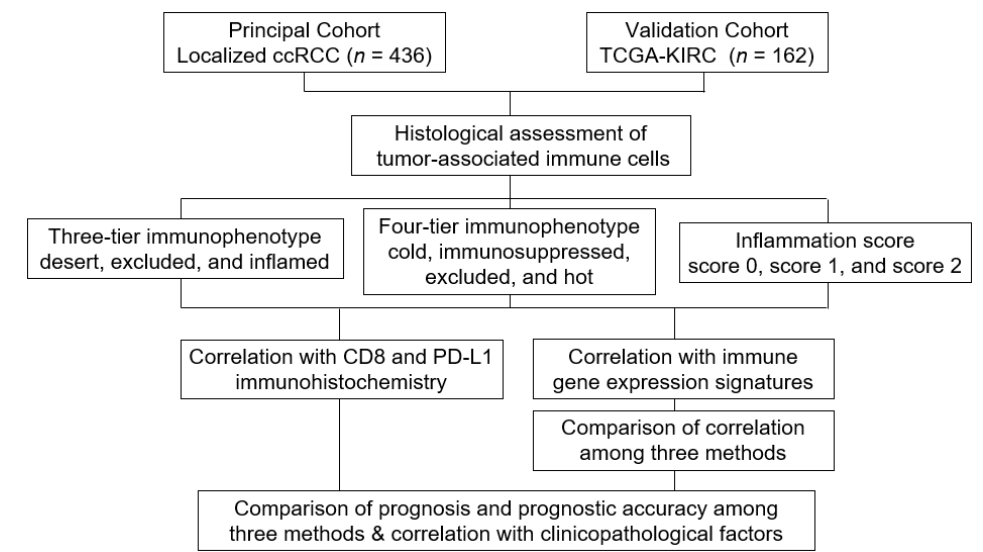
Figure 1. Study design.